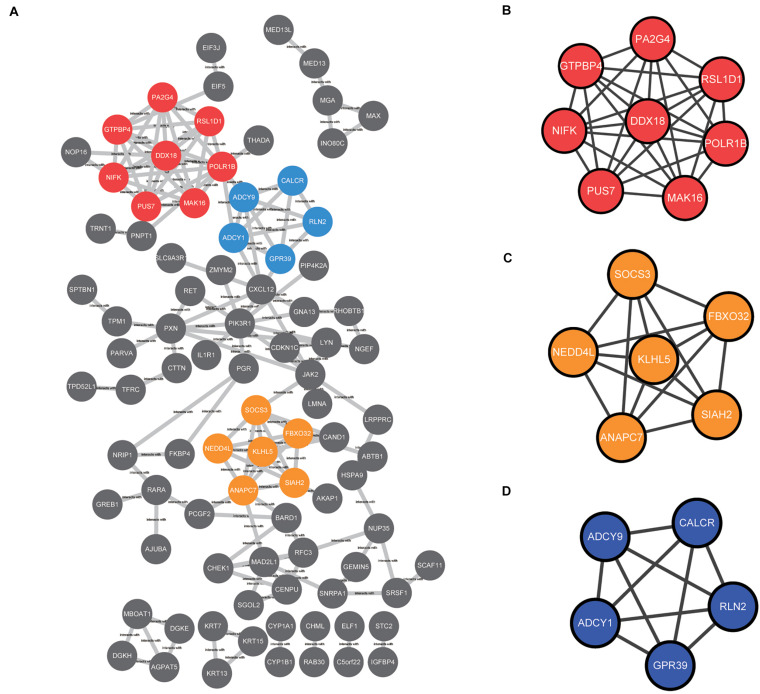
The protein–protein interaction (PPI) network among the common DEGs was constructed and then subjected to modular analysis with Cytoscape software and the MCODE plug-in (degree cutoff = 2, node score cutoff = 0.2, k-core = 2, and maximum depth = 100). (A) The PPI network complex, including 89 nodes and 149 edges. The nodes meant proteins; the edges meant the interaction of proteins; three major clusters were identified by MCODE plug-in and labeled by red, orange, and blue colors. (B) The cluster with the top MCODE score (score = 8.0) contained 8 nodes and 28 edges labeled red. (C) The cluster with the second-highest MCODE score (score = 6.0) contained 6 nodes and 15 edges labeled orange. (D) The cluster with the third-highest MCODE score (score = 5.0) contained 5 nodes and 10 edges labeled blue.